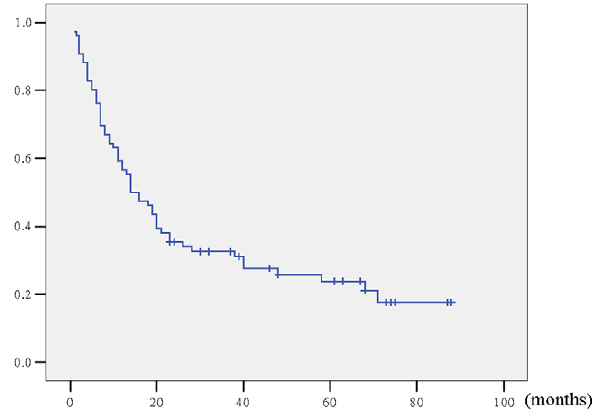
Figure 1. Actuarial survival curve of 76 gallbladder cancer patients following surgical resection with curative